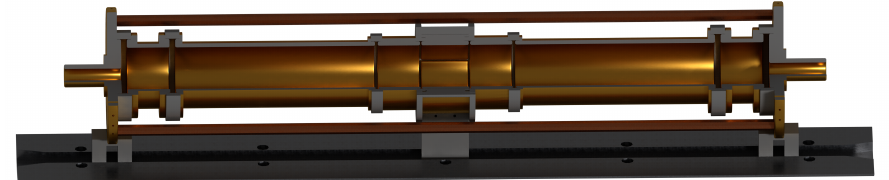
Figure 1. The 40cm long, cylindrical electrode stack that creates the electric field of the HITRAP cooling Penning trap with a central electrode segmented into four